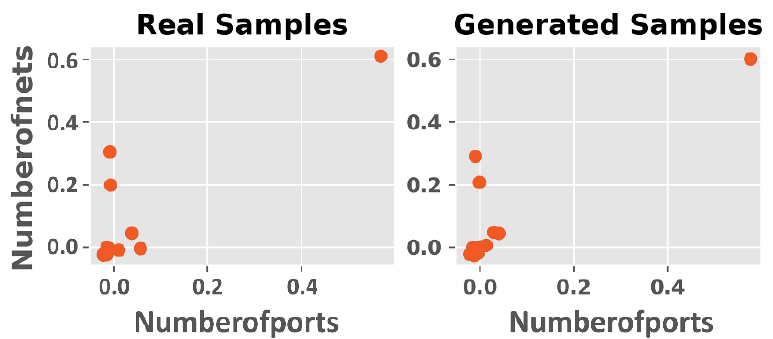
Figure 8. Discriminator loss values of our four models for each epoch.